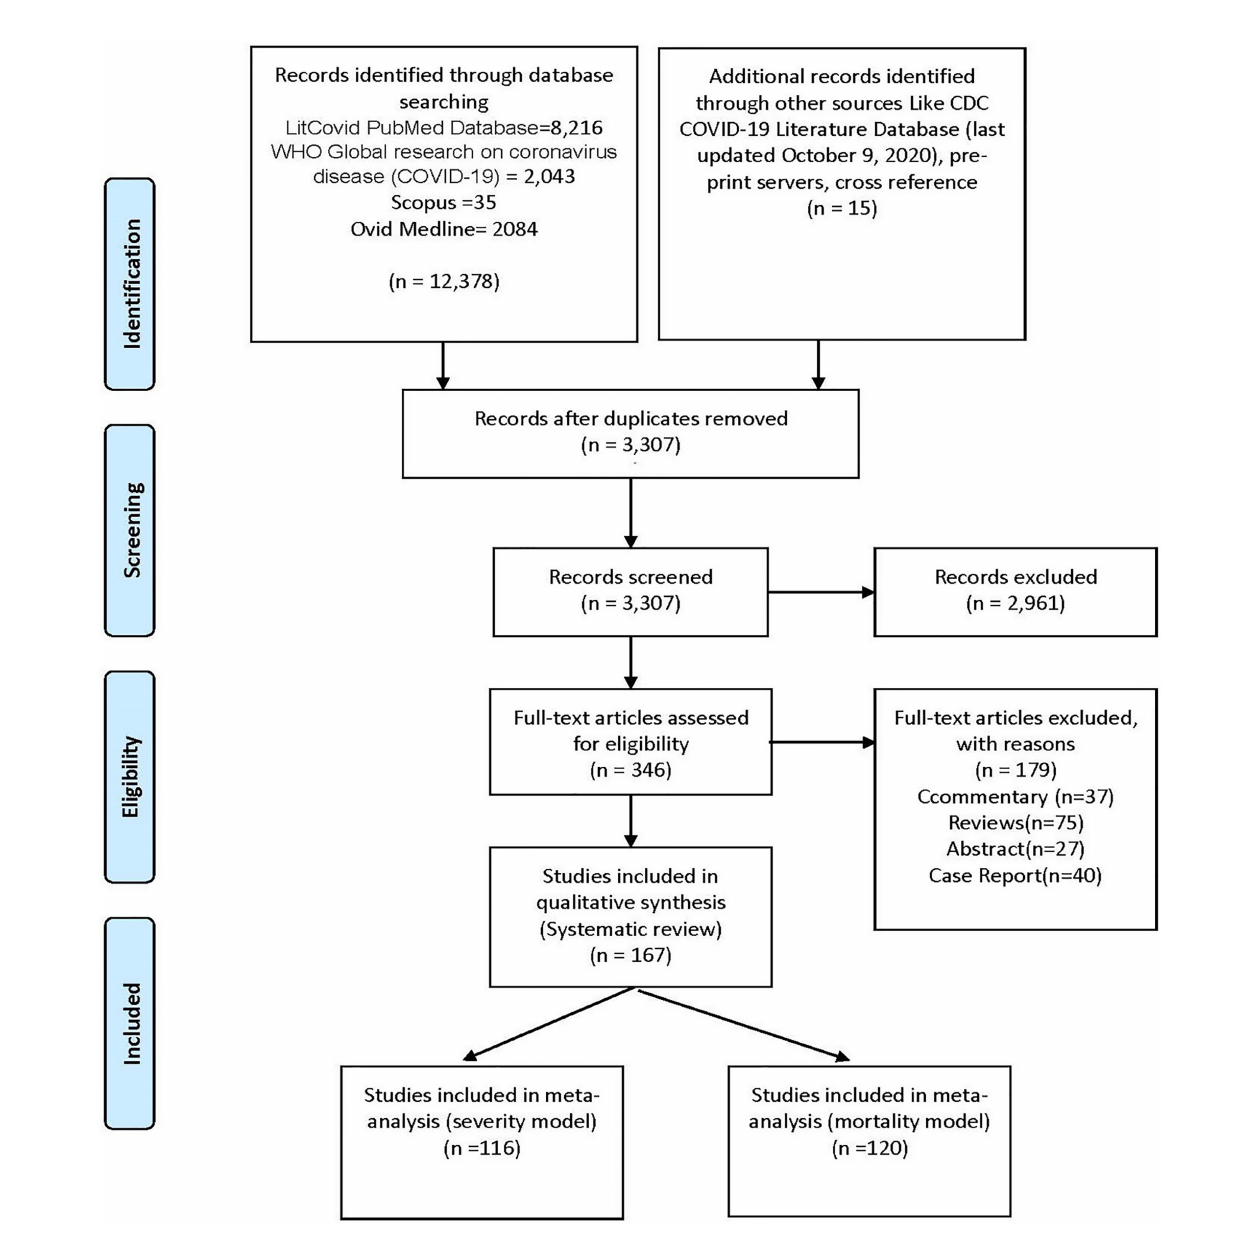
FIGURE 1 | Prisma fl ow